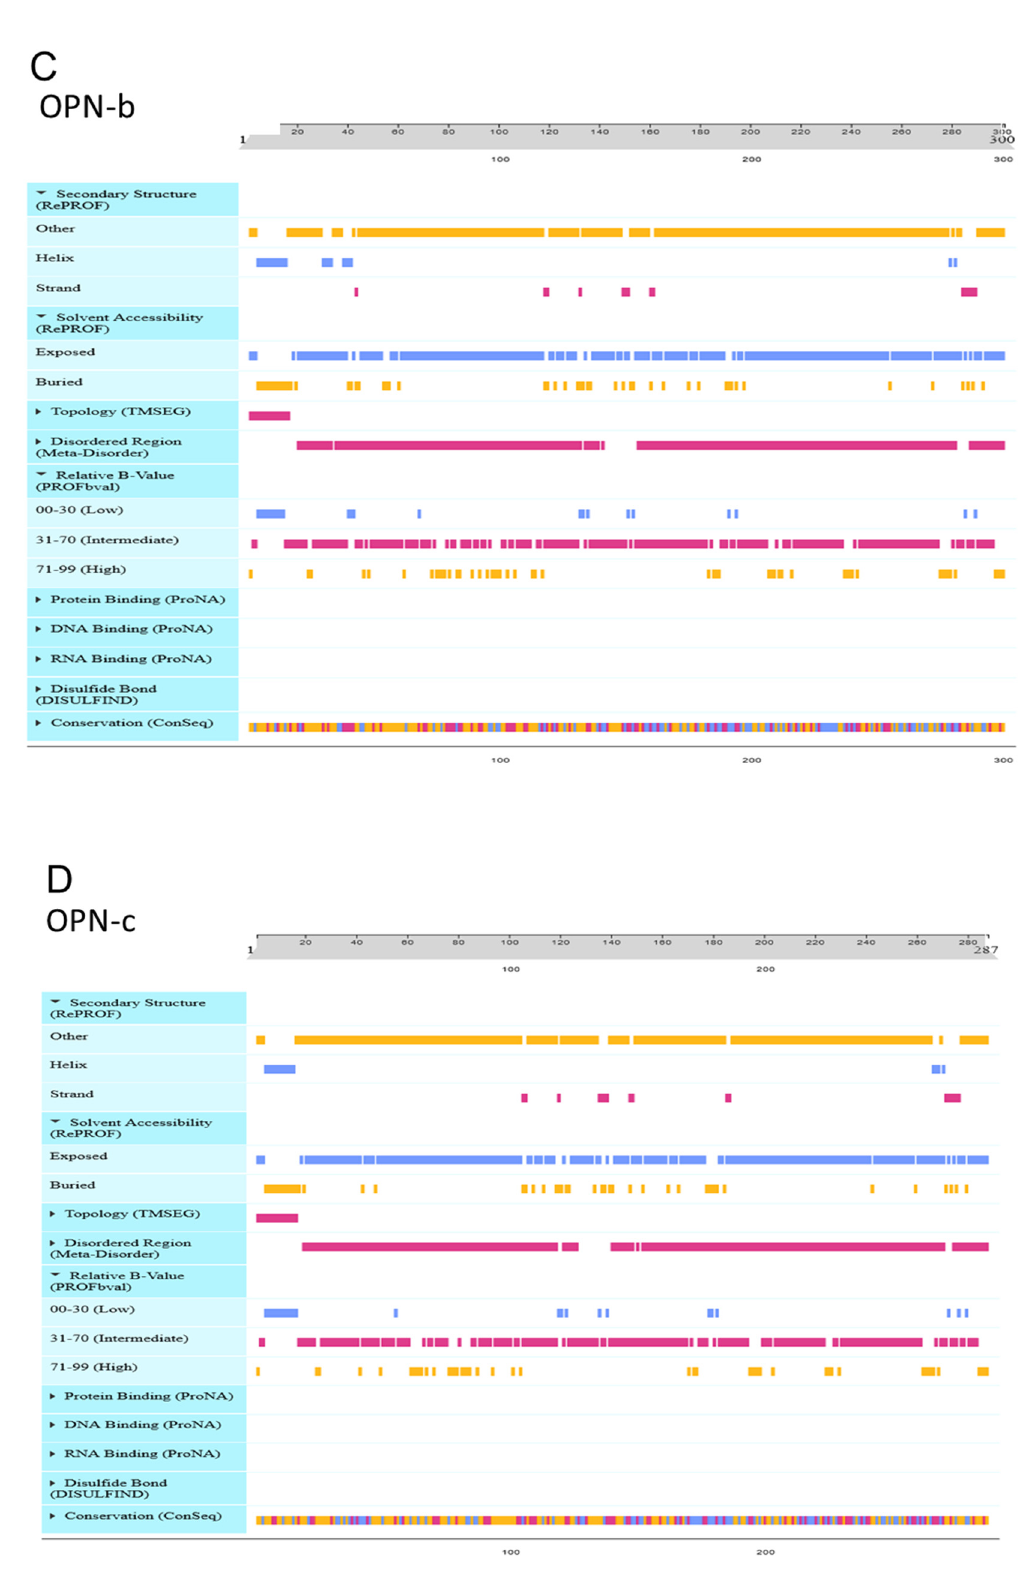
Figure 5. Prediction of the protein features of the OPN splice variants. ( A ) Protein sequences. ( B ) Protein features of OPN-a. ( C ) Protein features of OPN-b. ( D ) Protein features of OPN-c.